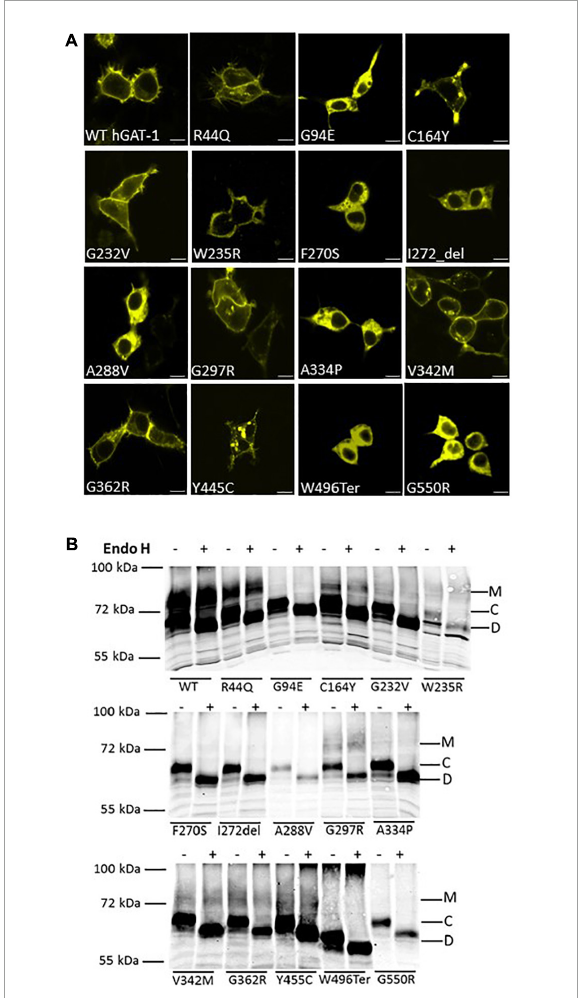
FIGURE2 Cellular localization of wild type and disease variants of human GABA transporter 1 (GAT-1). (A) HEK293 cell were transfected with plasmids encoding yellow fluorescent protein (YFP)-tagged GATs to visualize their expression. HEK293 cell were transfected with plasmids encoding N-terminally YFP-tagged WT hGAT-1 and 15 epilepsy mutants thereof. Scale bars represent 10 µ m. 24 h after transfection, the cells were seeded onto poly-D-lysine-coated ibidi R (cid:13) glass bottom chambers. Confocal laser scanning microscopy was performed as described under “2 Materials and methods”. WT hGAT-1 targets to the cell surface, while many of the epilepsy variants indicate an altered (i.e., intracellular) expression patterns. (B) Representative blots showing de-glycosylation patterns of WT hGAT-1 and epilepsy mutants with endoglycosidase (Endo) H. Detergent lysates